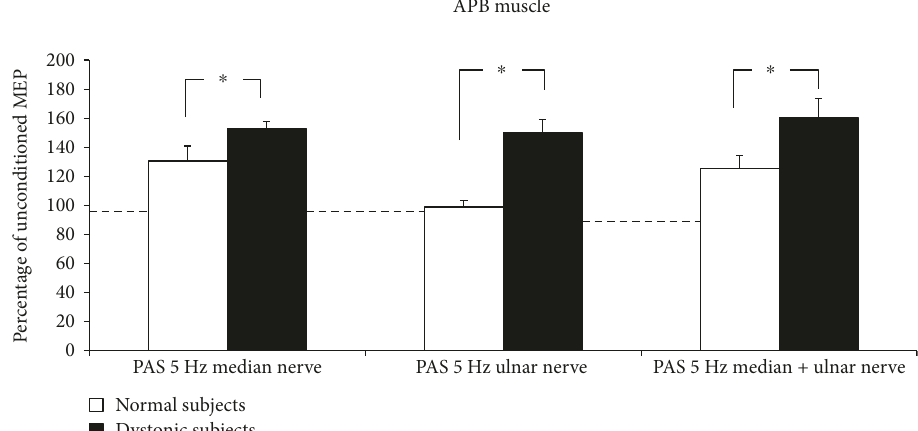
Figure 1: 5 Hz rPAS induced an increase in MEP size recorded from APB muscle in both patients and controls; repeated measure ANOVA showed a signi fi cant e ff ect of time [ F = 88 38 ; P < 0 001 ], but the amount of facilitation was di ff erent between the two groups, as shown by the time × group interaction [ F = 21 14 ; P < 0 001